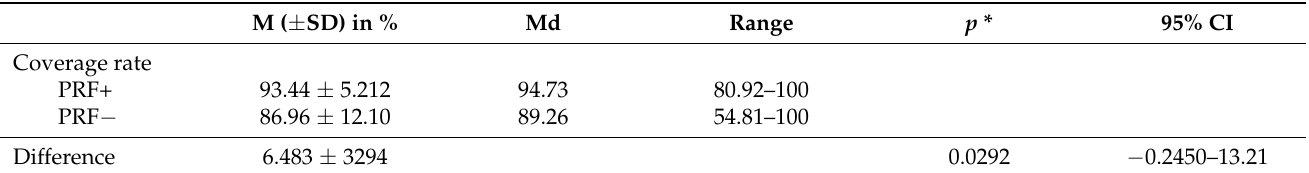
Table 4. Dehiscence: PRF vs.